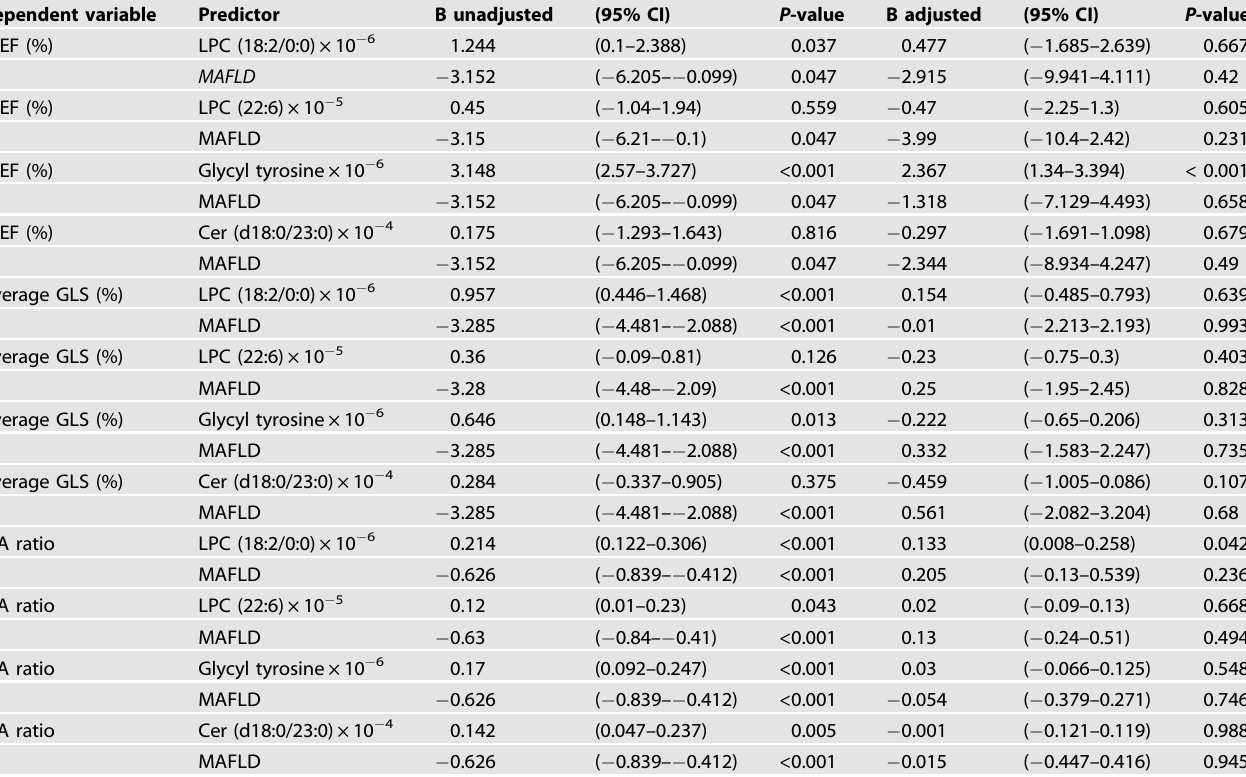
Table 4. Univariate and multivariate linear regression models predicting LVEF (%), average GLS (%), and E/A ratio for different metabolic biomarkers, adjusted for age (years), gender, BMI (kg/m2), SBP (mmHg), DBP (mmHg), diabetes, MAFLD vs.